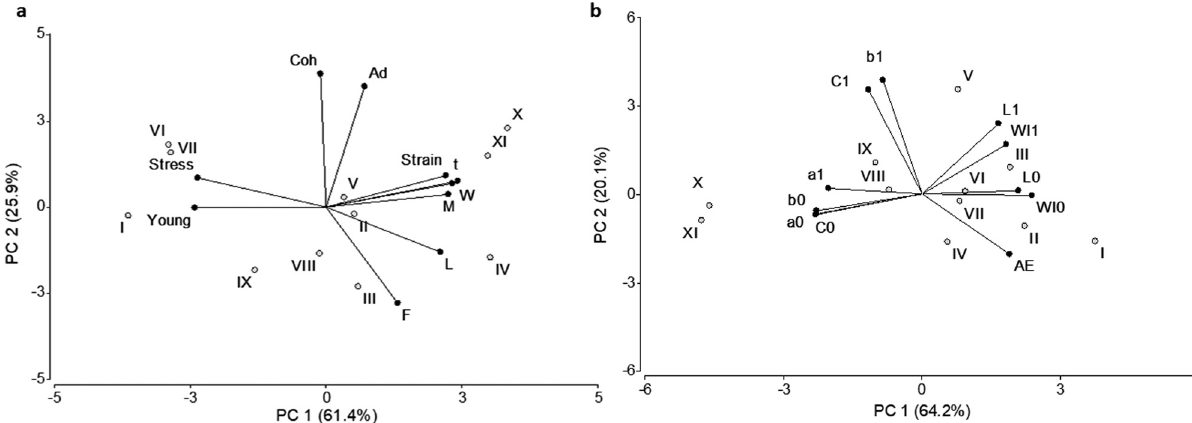
Figure 1: PCA of ( a ) the texture parameters ( adhesiveness [ ad ] ; fi rmness [ F ] ; cohesiveness [ Coh ] ; fracture stress [ stress ] ; facture strain [ strain ] ; and Young ’ s modulus [ Young ]) ; dimensions ( length [ L ] ; thickness [ t ] ; weigh [ W ]) , and moisture content [ M ] and ( b )